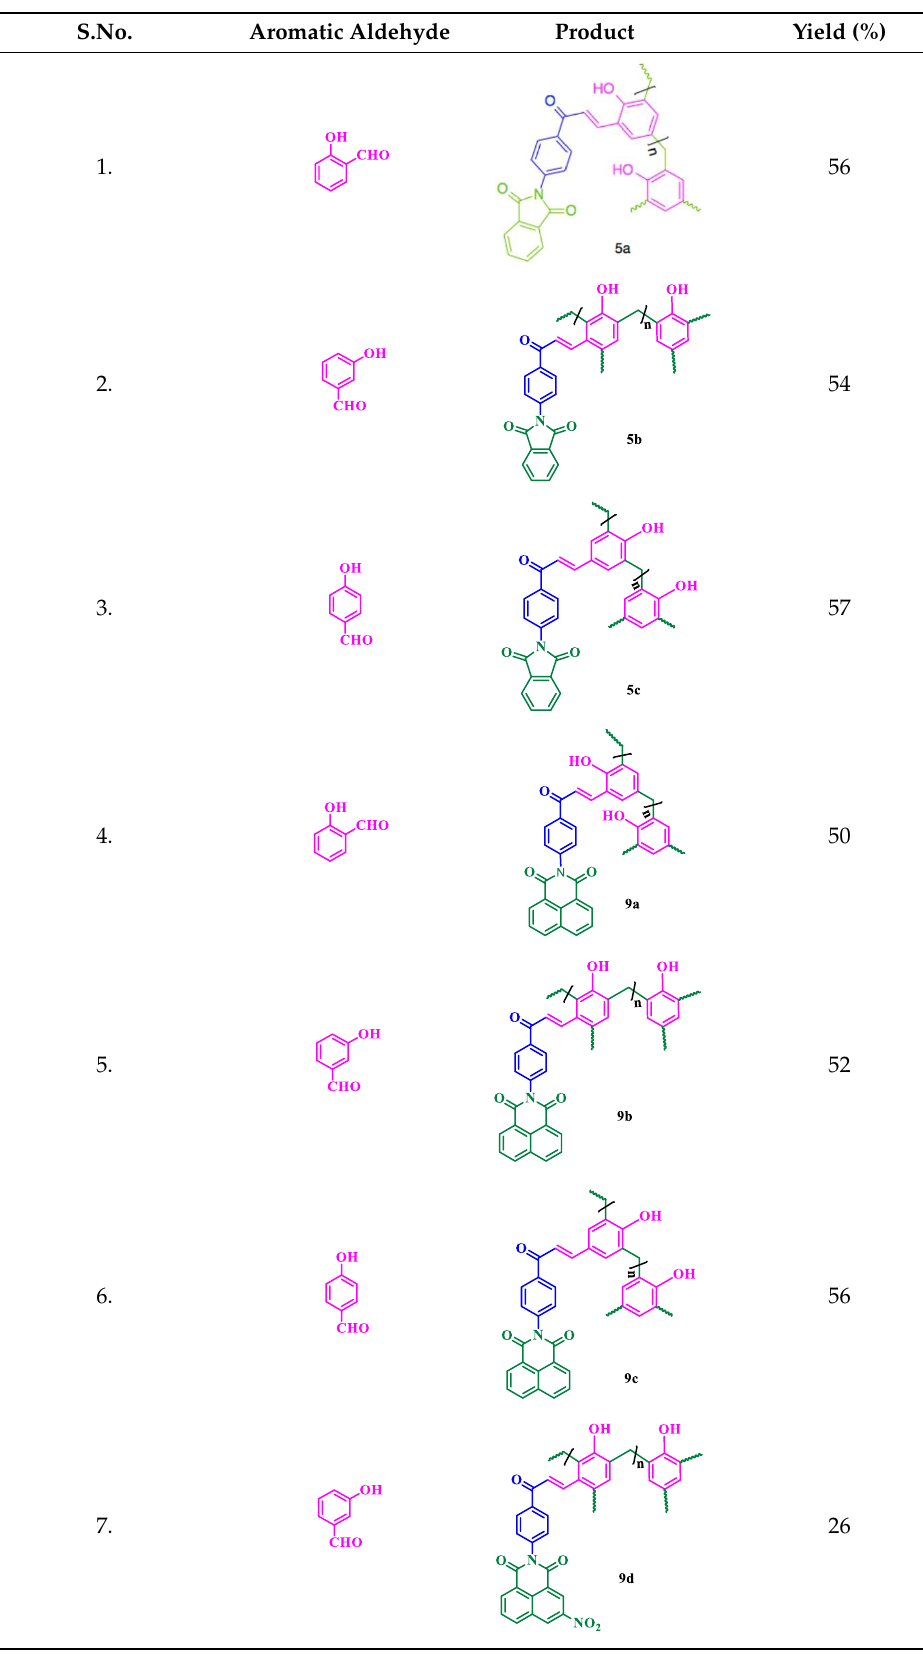
3.2. Average Molecular Weight Analysis The average molecular weights (M n and M w ) and polydispersity index (Ð = M w /M n ) of the synthesized polymers were calculated and the results are presented in Table 2. The chromatogram of novolac 5a is presented in Figure 3. Table 2. Molecular weight M n , M w , and Ð of the synthesis novolac polymers 5a − c and 9a − d . (Re- sults are expressed as rounded to the third significant number). Polymer